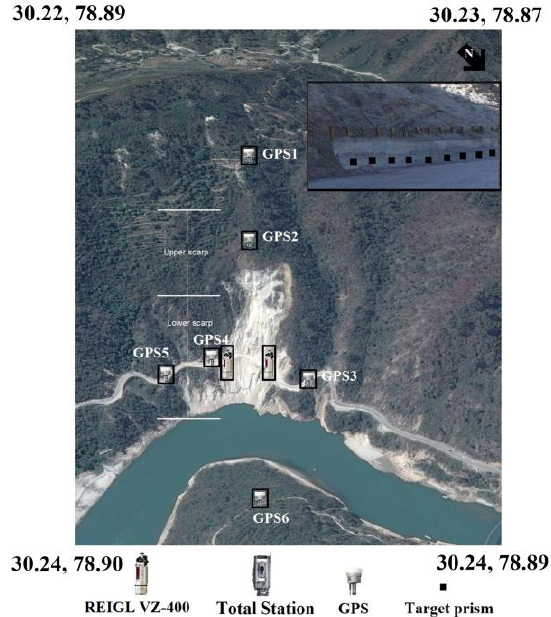
Figure 1. An oblique Google earth view of the study area. Large black rectangular box shows the retaining wall and the installed target